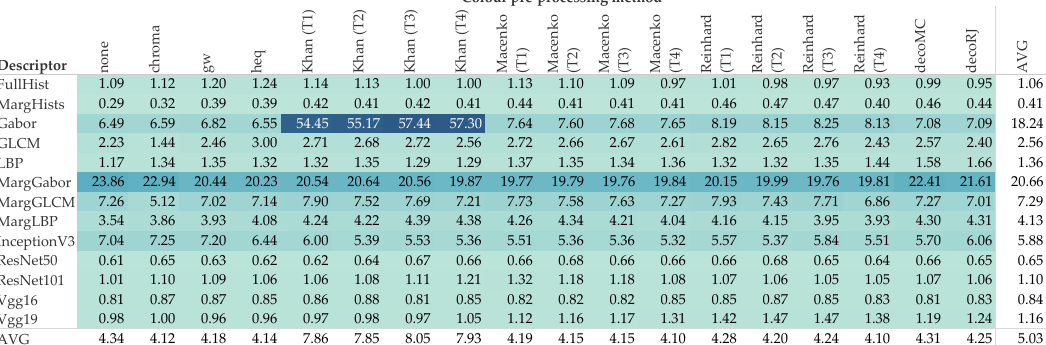
Figure 10. Feature extraction time (sec/image). The values were recorded on the HICL dataset. Please note that for efficiency reasons, the color-preprocessed images were cached after the first calculation, which was carried out during the extraction of ‘Gabor’ features. Therefore, the figures in the ‘Gabor’ row include both the color pre-processing time and the feature extraction